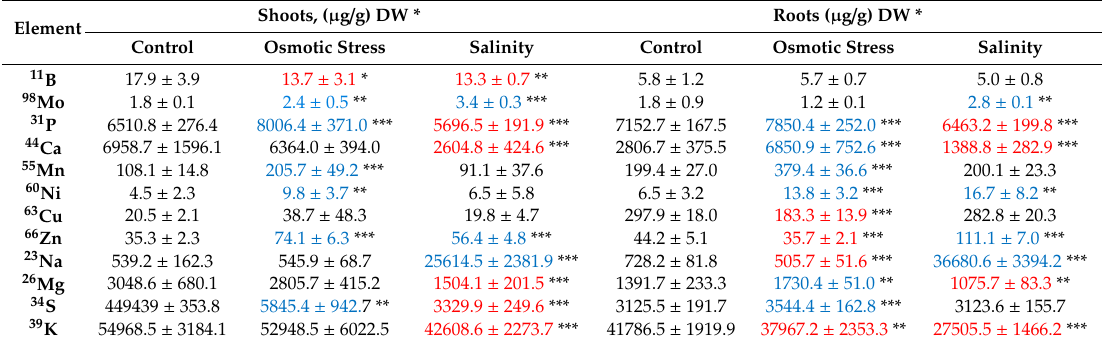
Table 1. Element compositions in shoots and roots of Hordeum marinum under osmotic and salinity stress compared to control.